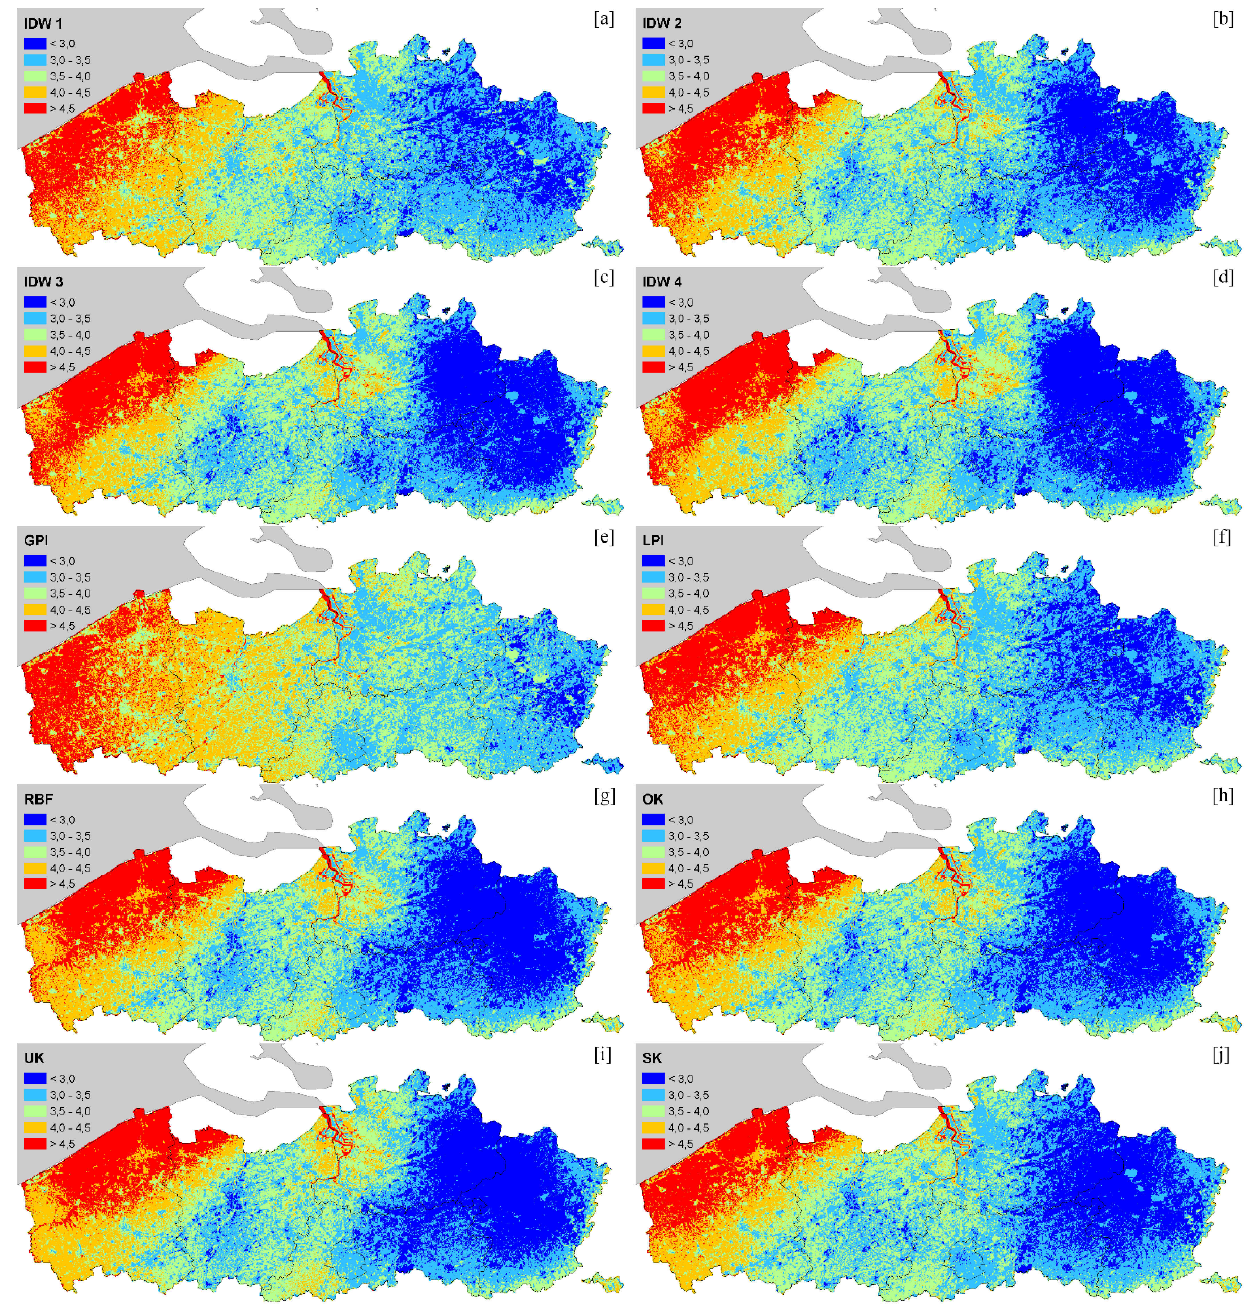
Figure 5. Yearly mean surface wind speed generated using different spatial interpolation methods. ( a ) Inverse Distance Weighted IDP = 1. ( b ) Inverse Distance Weighted IDP = 2. ( c ) Inverse Distance Weighted IDP = 3. ( d ) Inverse Distance Weighted IDP = 4. ( e ) Global Polynomial Interpolation. ( f ) Local Polynomial Interpolation. ( g ) Radial Basic